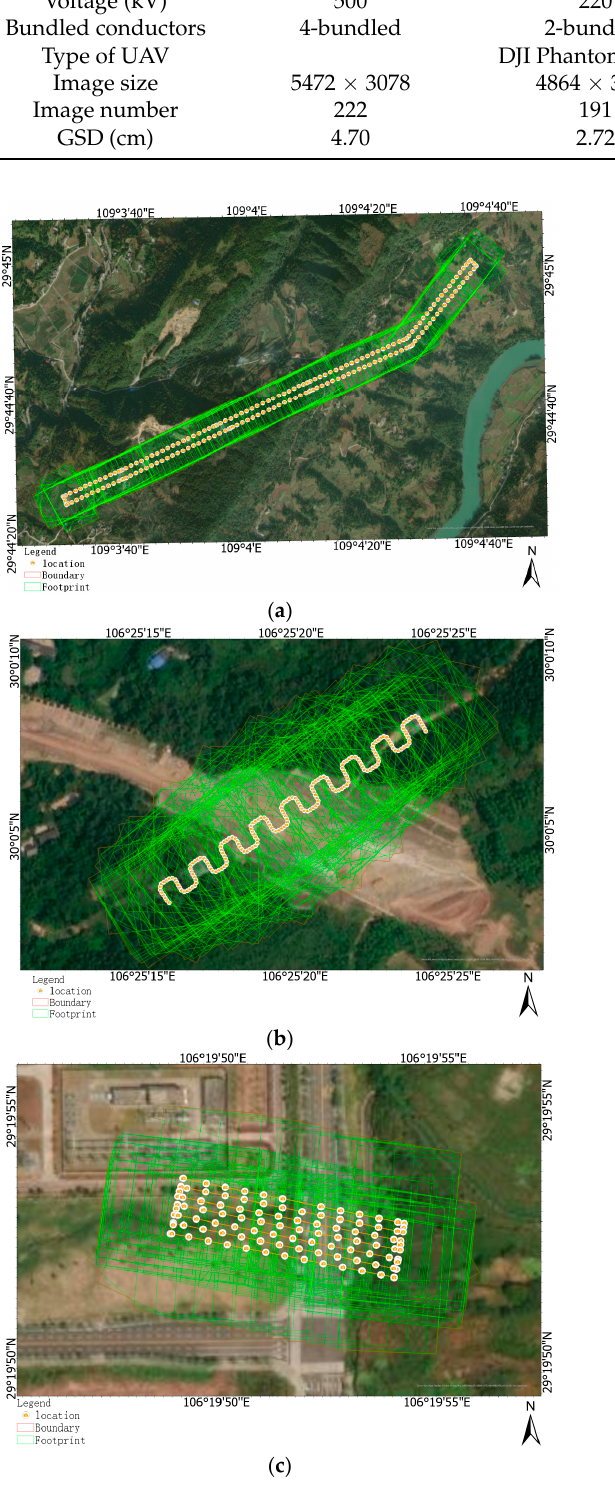
Figure 1. UAV images of the three test sites. ( a – c ) are the rectangle dataset in test site 1, S-shaped dataset in test site 2, and traditional multiple trajectories dataset in test site 3, respectively. Table 1. Details of the three test sites.